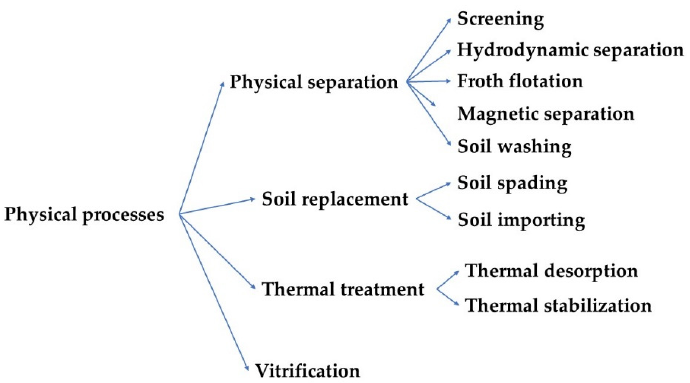
Figure 2. Physical processes to remove heavy metals and metalloids.